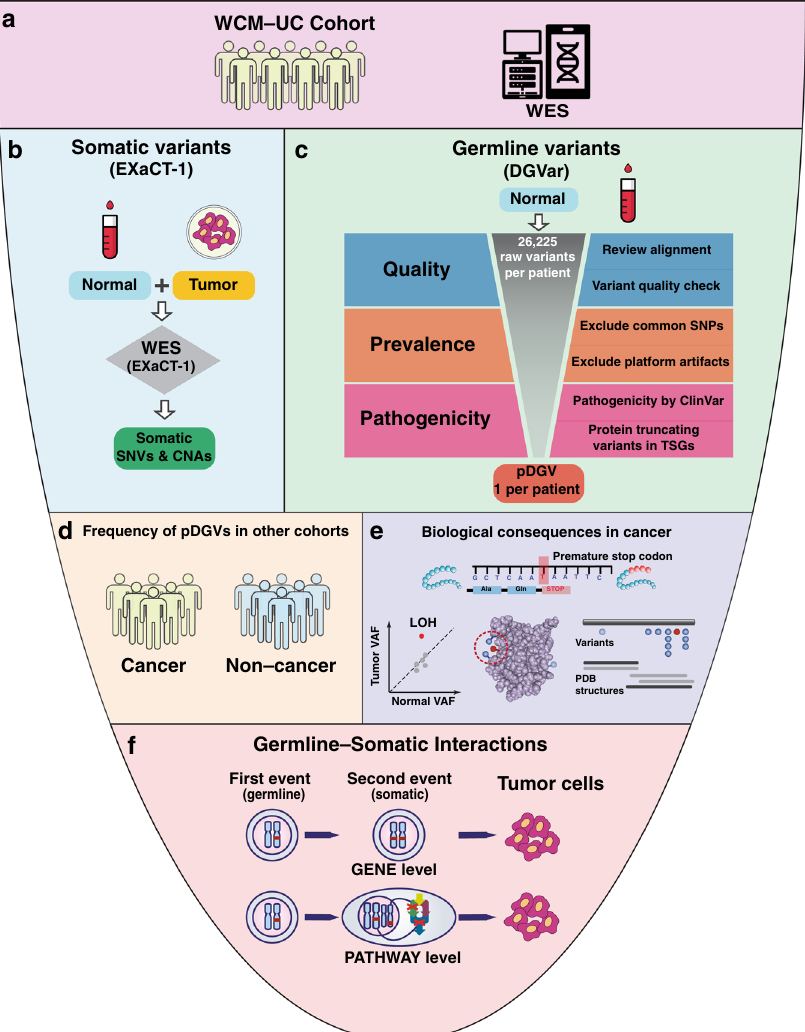
Fig. 1 Comprehensive analysis of germline-somatic interactions in urothelial cancer. a WES of 157 germline samples from 80 UC patients (WCM-UC cohort) b Somatic variants identi fi ed through EXaCT-1 whole-exome sequencing (WES) pipeline using matched tumor-normal samples. c The DGVar framework for the identi fi cation of putative deleterious germline variants (pDGVs). d Comparison cohorts: 398 patients from the TCGA-BLCA cohort, and 11,035 noncancer subjects from the SPARK non-cancer cohort. e Functional predictions using CADD scores, three-dimensional modeling of the effects of pDGVs on protein data bank (PDB) structures and somatic LOH analysis f Germline-somatic interactions at the gene and pathway